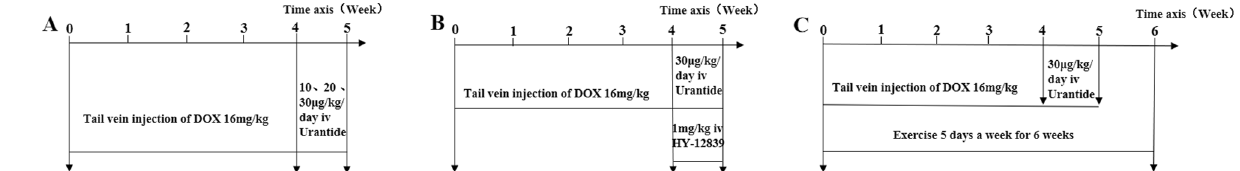
Figure 1. The study flow diagram for animal experiments. ( A ) The treatment groups were injected Urantide at 10, 20, and 30 μg/kg/day for 7 days consecutively. ( B ) The treatment groups were injected Urantide and (or) p38 MAPK-IN-1. ( C ) The treatment groups were injected Urantide and (or)